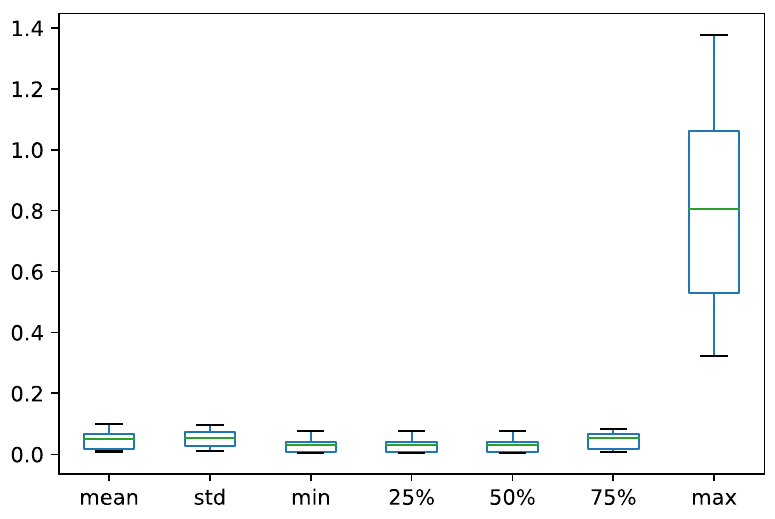
Figure A9. Variations between the distribution of percentage of author contribution per subreddit (outliers are omied).